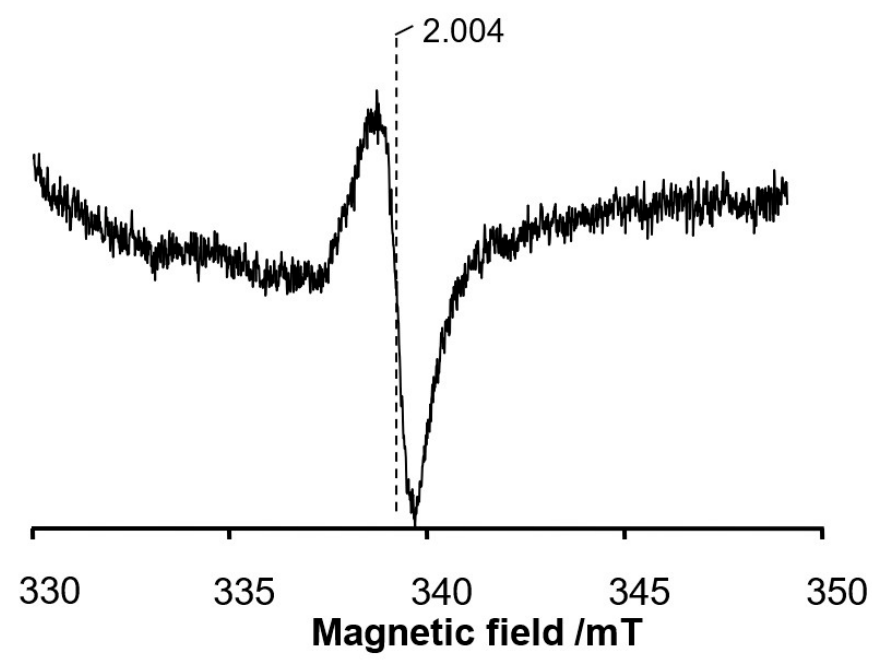
Figure 4. EPR spectrum of Zn-C14A mixed after the radical generator. The reaction solution was frozen 30 min after the mixing. The spectrum was recorded at 10 K. Microwave power 0.5 mW; Field modulation 0.2 mT; modulation frequency 100 kHz.